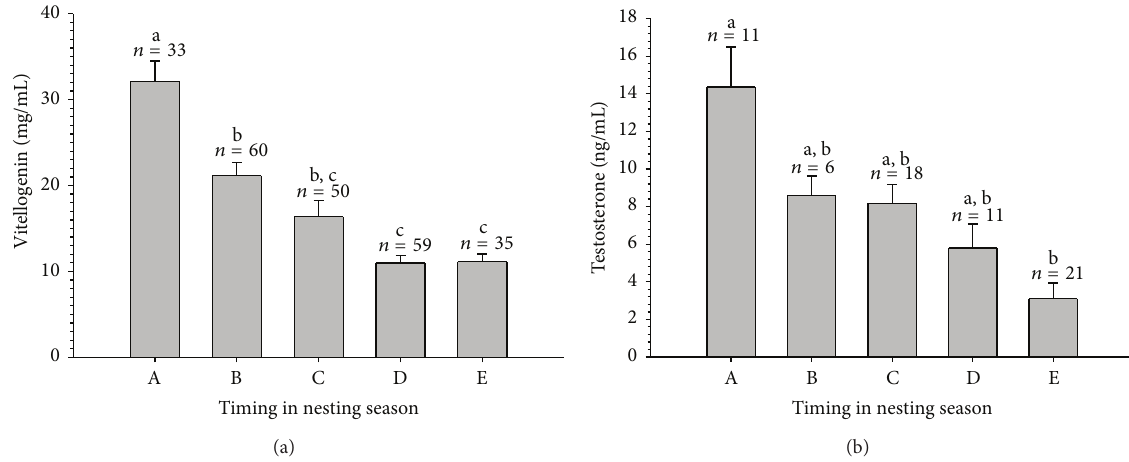
Figure 4: (a) Mean vitellogenin and (b) mean testosterone concentrations measured in nesting females over the nesting season were parsed every two weeks. Error bars represent the standard error of the mean and different letters represent significantly different groups. (A = BeginningJune–MidJune;B=MidJune–EndJune;C=BeginningJuly–MidJuly;D=BeginningAugust–MidAugust;E=BeginningAugust– Mid August.) Both testosterone and vitellogenin concentrations decreased in nesting females as the nesting season progressed. Vitellogenin concentration was significantly higher in nesting turtles sampled in June compared to those measured in turtles caught in July and August. Testosterone concentration was significantly higher in nesting females sampled during the first two weeks of June in comparison to the end of June and all of July and beginning of August.